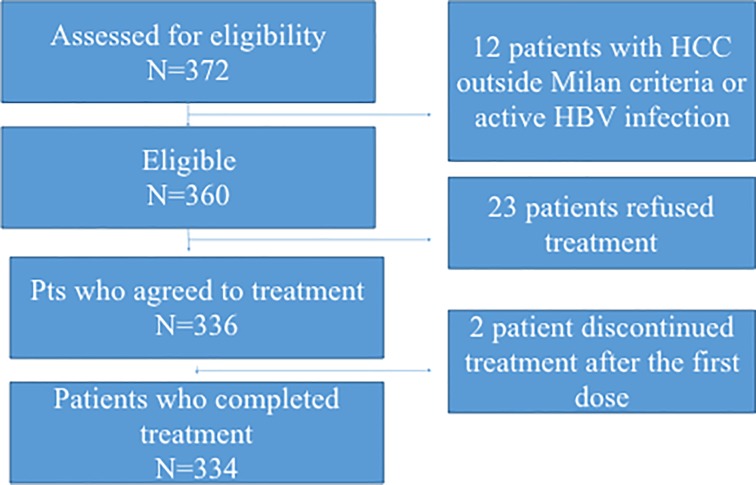
Study flow chart.